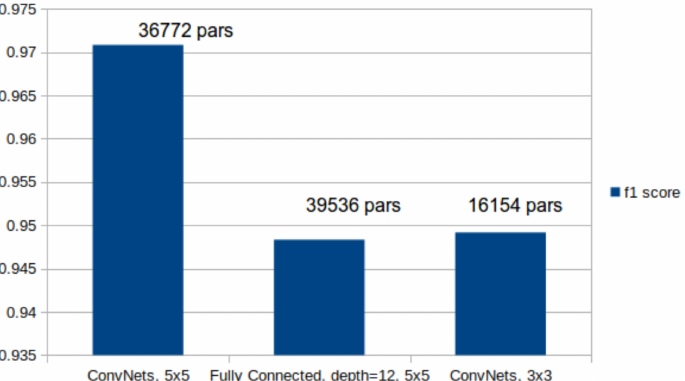
Figure 15. Bar graph of F1-score for different ConvNets and FC architectures